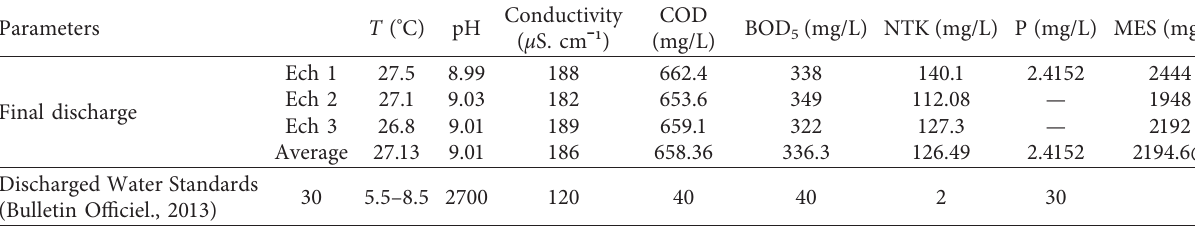
Table 5: Results of the physicochemical characterization of the industrial effluent.